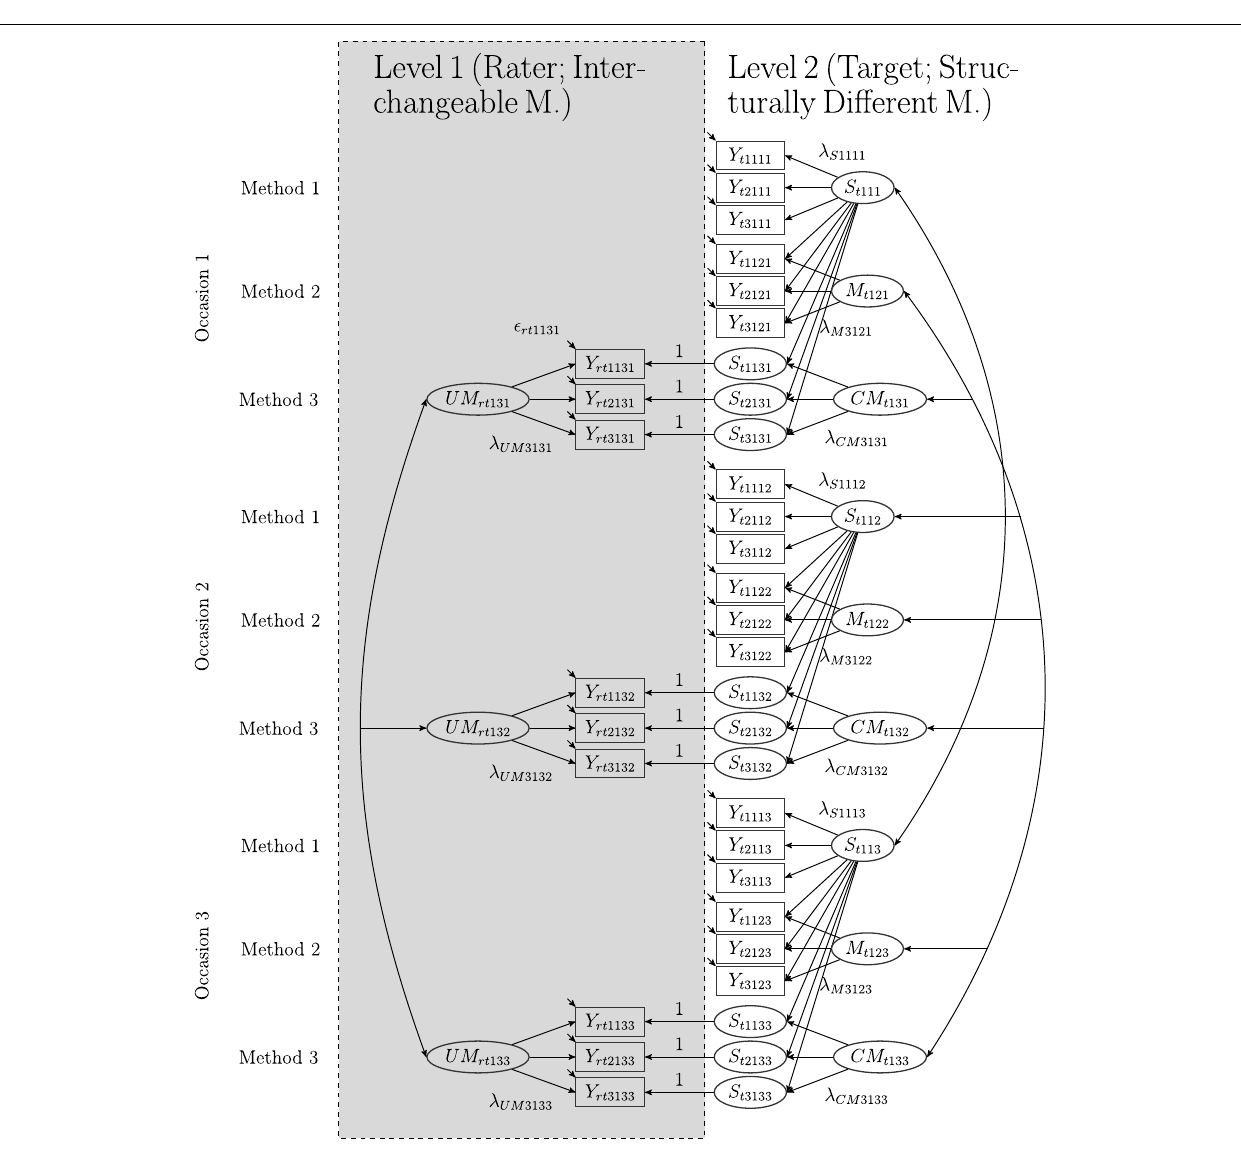
FIGURE 4 | The LS-COM model with latent state factors and three indicators ( i = 3), one construct ( j = 1), two structurally different and one set of interchangeable methods ( k = 3), and three occasions of measurement ( l = 3), where r : rater and t : target. Y rtijkl : observed variables at Level 1, Y tijkl : observed variables at Level 2, S tjkl : latent state factors, λ Sijkl : state factor loadings, M tjkl : latent method factors, λ Mijkl : method factor